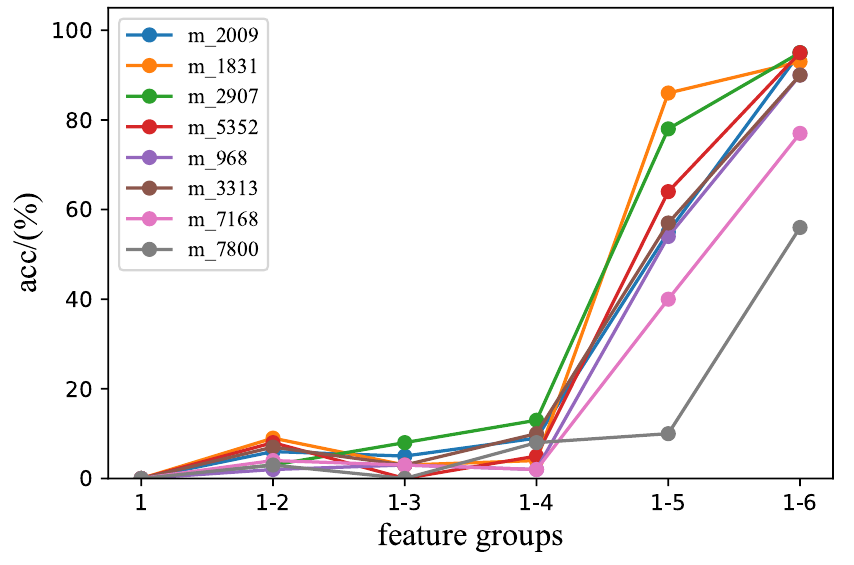
Figure 4. Performance comparison using different